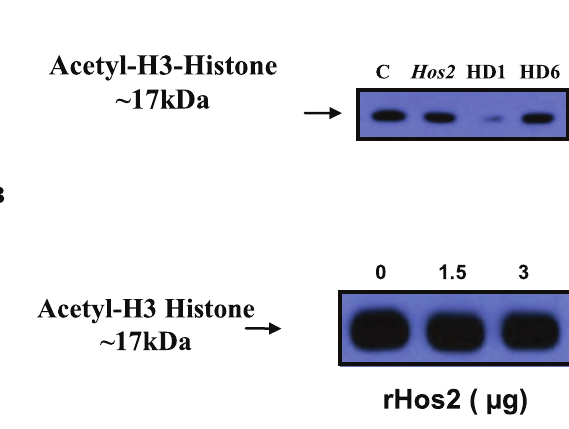
Table 2. IC values of standard HDAC inhibitors. 50